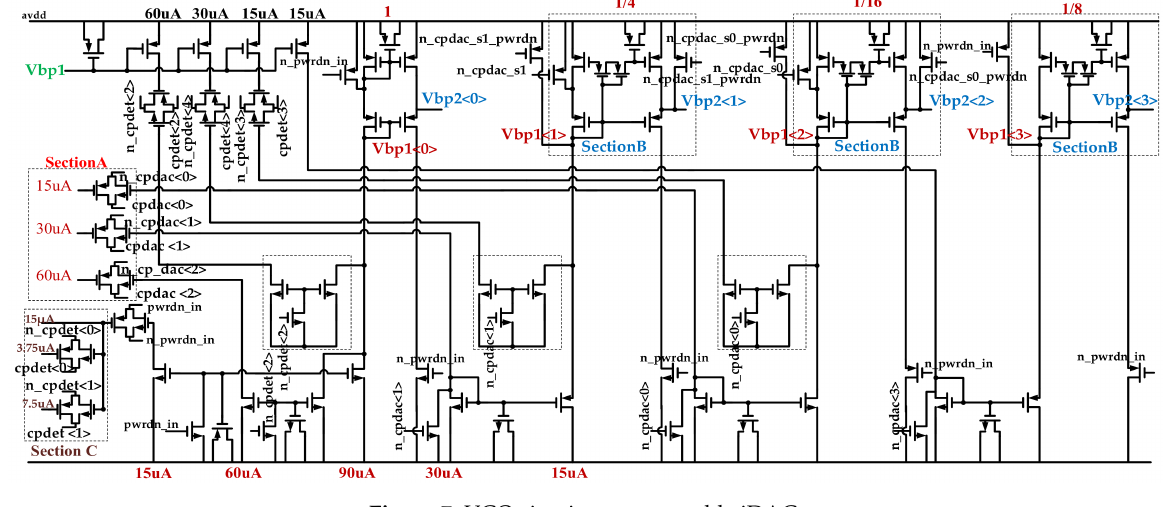
Figure 7. VCO circuit programmable iDAC.